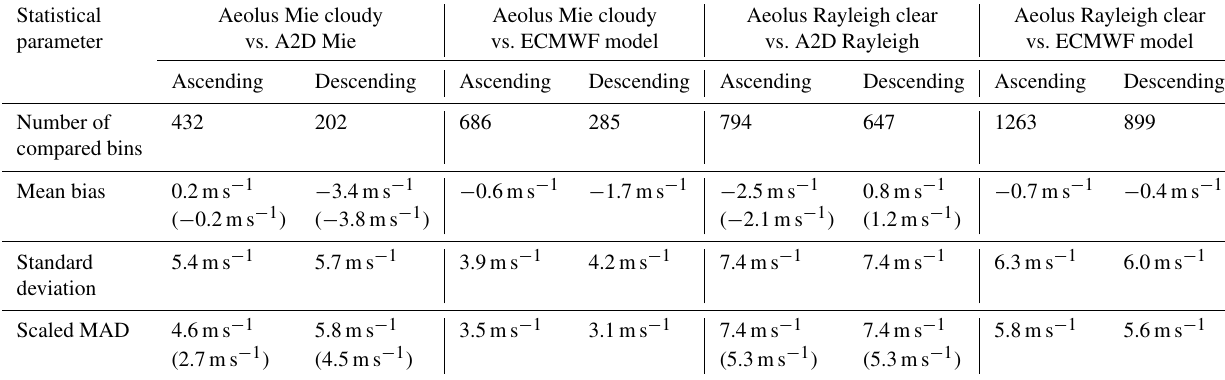
Table 5. Statistical comparison of the Aeolus L2B Mie-cloudy and Aeolus L2B Rayleigh-clear winds against the A2D Mie and Rayleigh, as well as the ECMWF model background winds, for all underflights performed during the AVATARI campaign. The corresponding scatterplots of the Aeolus–A2D comparison are shown in Fig. 12. The statistics are derived after adaptation of the A2D and ECMWF model data to the respective L2B measurement grids, i.e. a vertical bin thickness of 500m. The mean bias and scaled MAD for the Aeolus–A2D comparison are additionally provided after consideration of the A2D bias and random error with respect to the 2µm DWL and given in